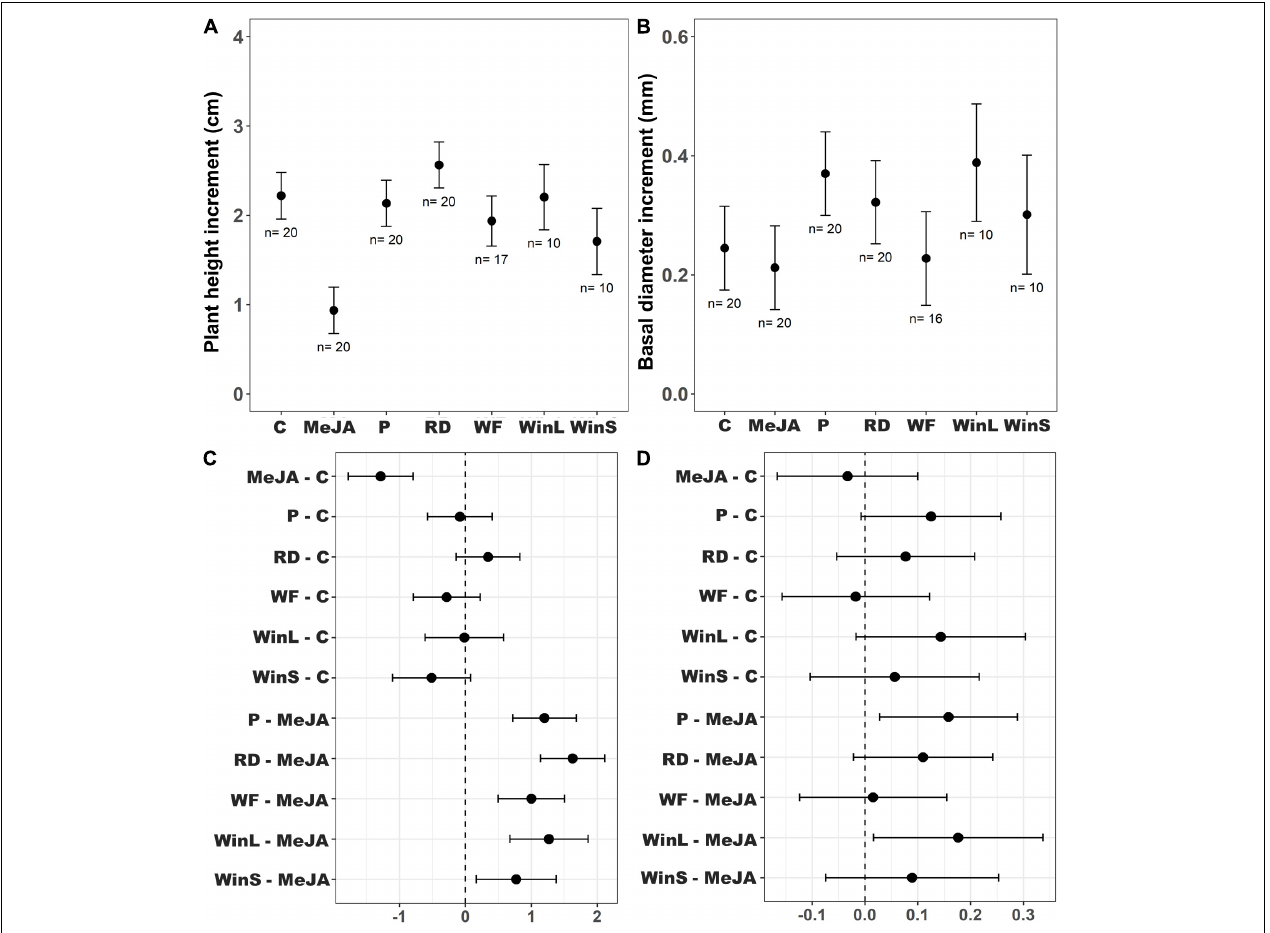
FIGURE 2 | Growth increment of Scots pine ( P. sylvestris ) seedlings and treatment mean comparisons using Dunnett’s test among different plant defense induction treatments [Undamaged seedlings as controls (C), 10 mM MeJA (MeJA), needle-piercing damage to the stem bark (P), root bark damage (RD), previous weevil feeding damage (WF), large stem window damage (WinL), and small stem window damage (WinS)] in experiment 1. Insect feeding tests were conducted at one time point, 12 days post-treatment. The growth of seedlings was followed for 21 days post-treatment. Sample sizes ( n ) used in the statistical analyses are also shown. (A) Estimated mean plant height increment (cm ± 95% confidence intervals), (B) estimated mean basal diameter increment (mm ± 95% confidence intervals), (C) differences between treatments in estimated mean height increments (cm ± 95% confidence intervals), and (D) differences between treatments in estimated mean diameter increments (mm ± 95% confidence intervals). If an interval does not include zero, the difference between estimated means is considered to be statistically